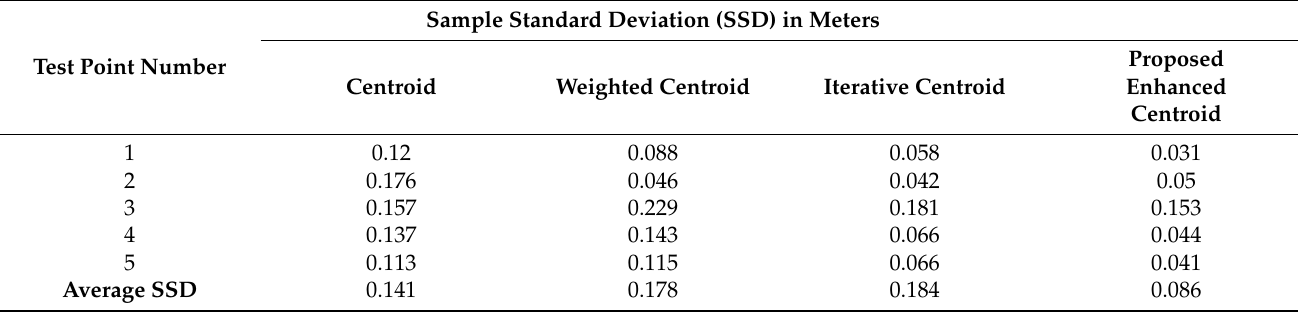
Table 5. The sample standard deviation (SSD) of the four positioning algorithms at five test points in the office room.